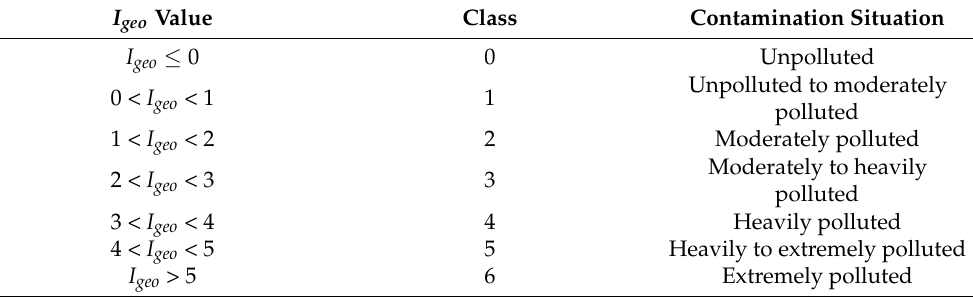
Table 2. Classification criteria for the geoaccumulation index ( I geo ).